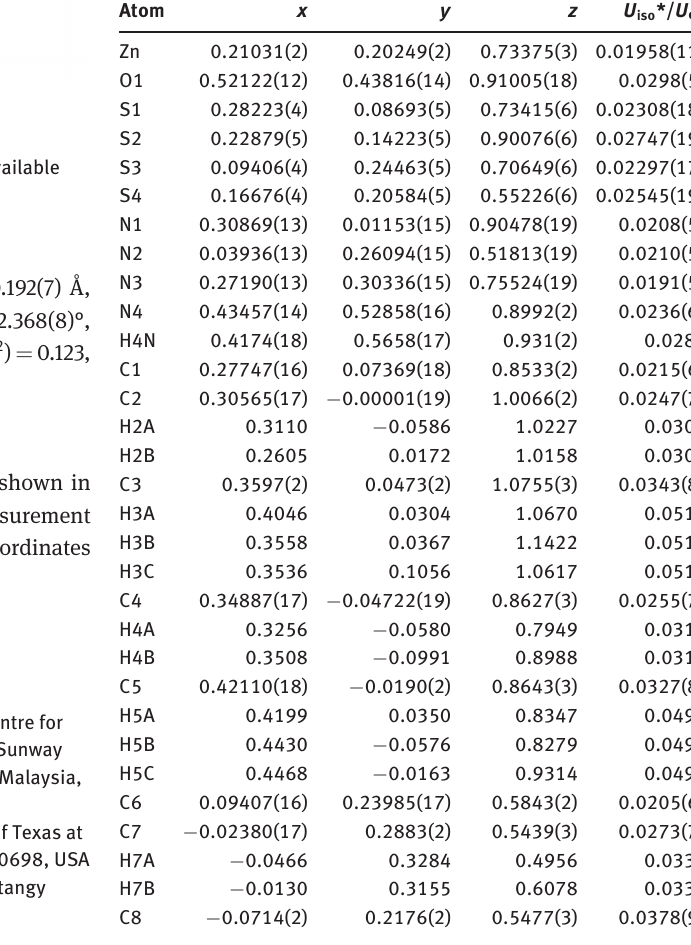
Table 2: Fractional atomic coordinates and isotropic or equivalent isotropic displacement parameters (Å 2